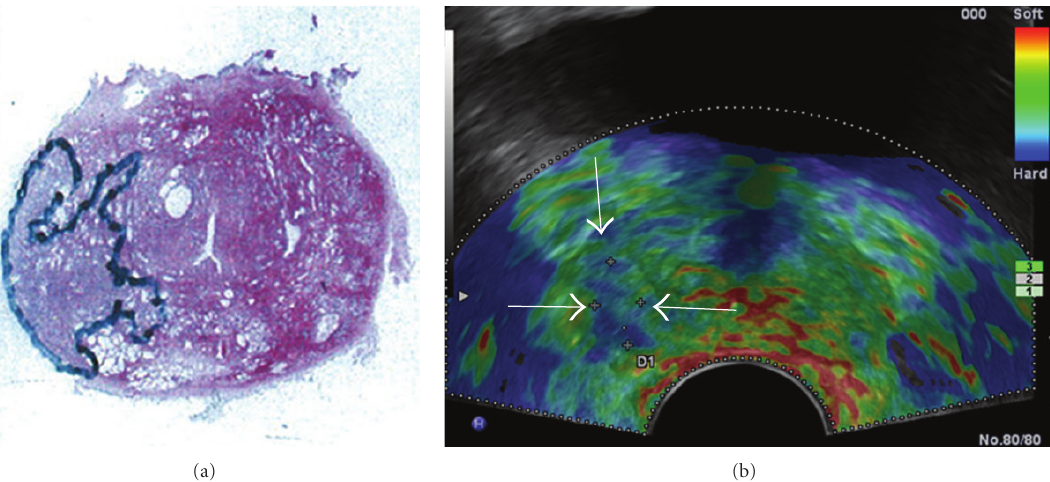
Figure 4: Outlined large cancer lesion PZ midgland right on whole-mount step section shown on (a) and corresponding hard area (white arrows) on elastogram (b) in axial planes.